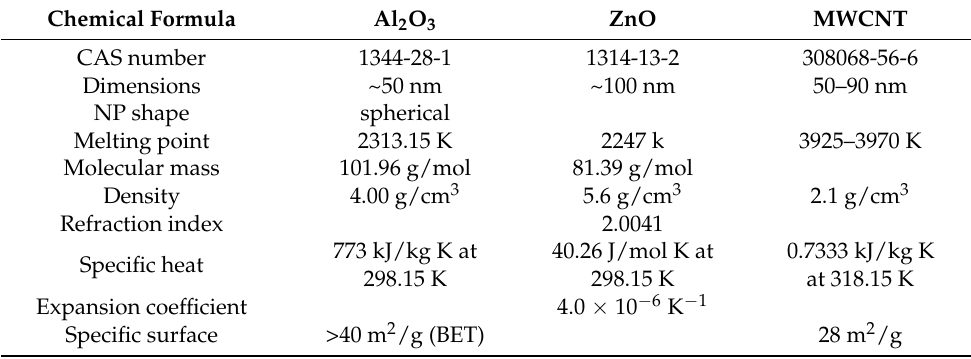
Table 2. Properties of nanoparticles according to the